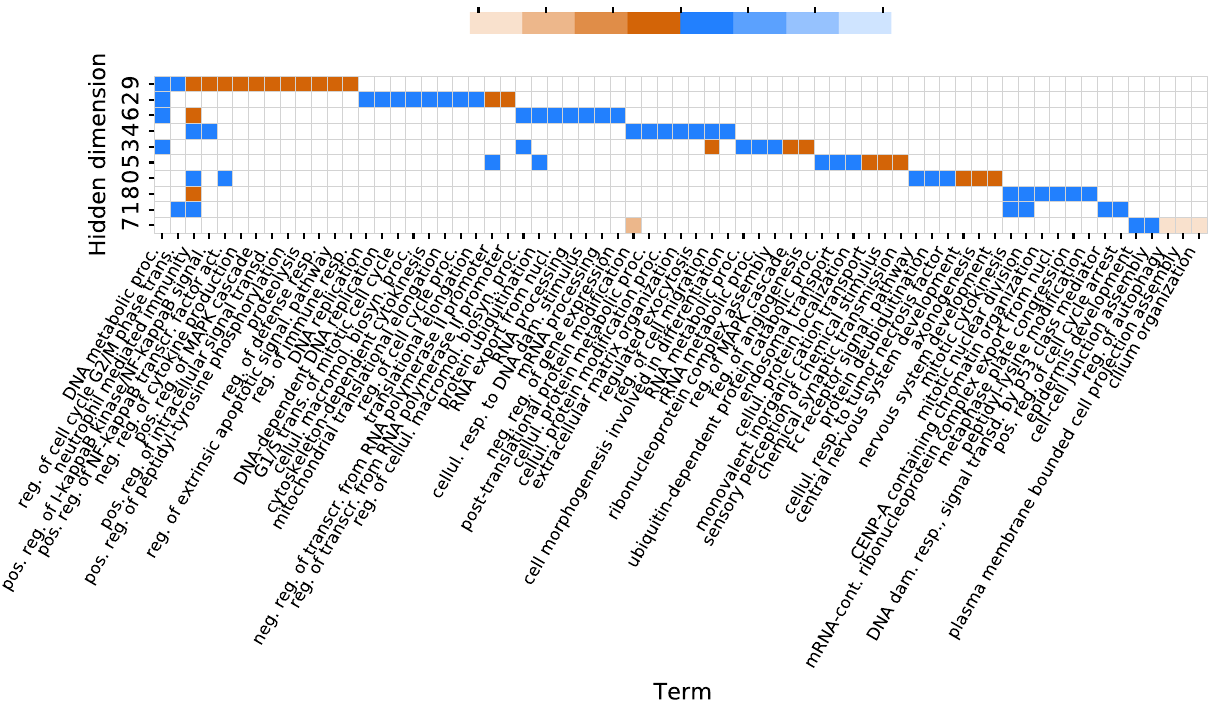
Figure 2. Heatmap reflecting Biological Process GO terms enriched in hidden dimensions of the cell line autoencoder. Negatively and positively signed FDR values correspond to negative and positive enrichment scores, i.e. negative and positive side of the ranked list, respectively. Hidden dimensions are sorted by the number of enriched terms. Abbreviations: proc. – process, reg. – regulation, resp. – response, neg. –